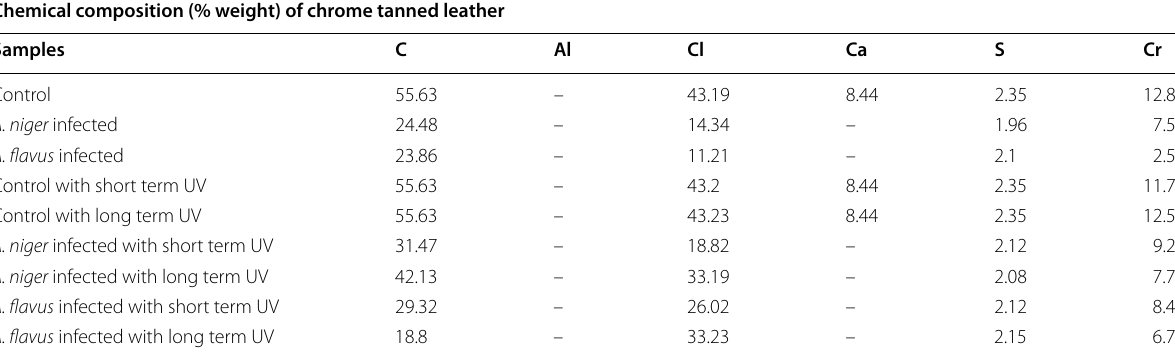
Table 4 Elemental analysis of chrome tanned leather sample after 30 days Chemical composition (% weight) of chrome tanned leather